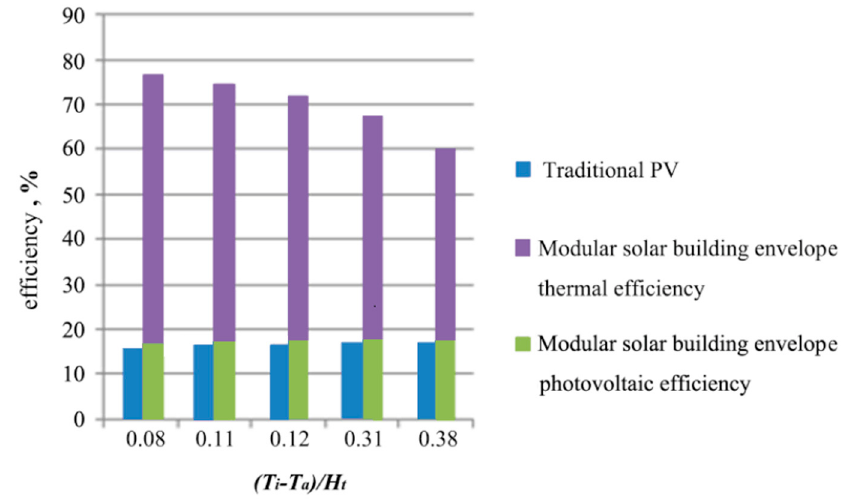
Figure 11. Efficiency comparison of module system and conventional PV system.